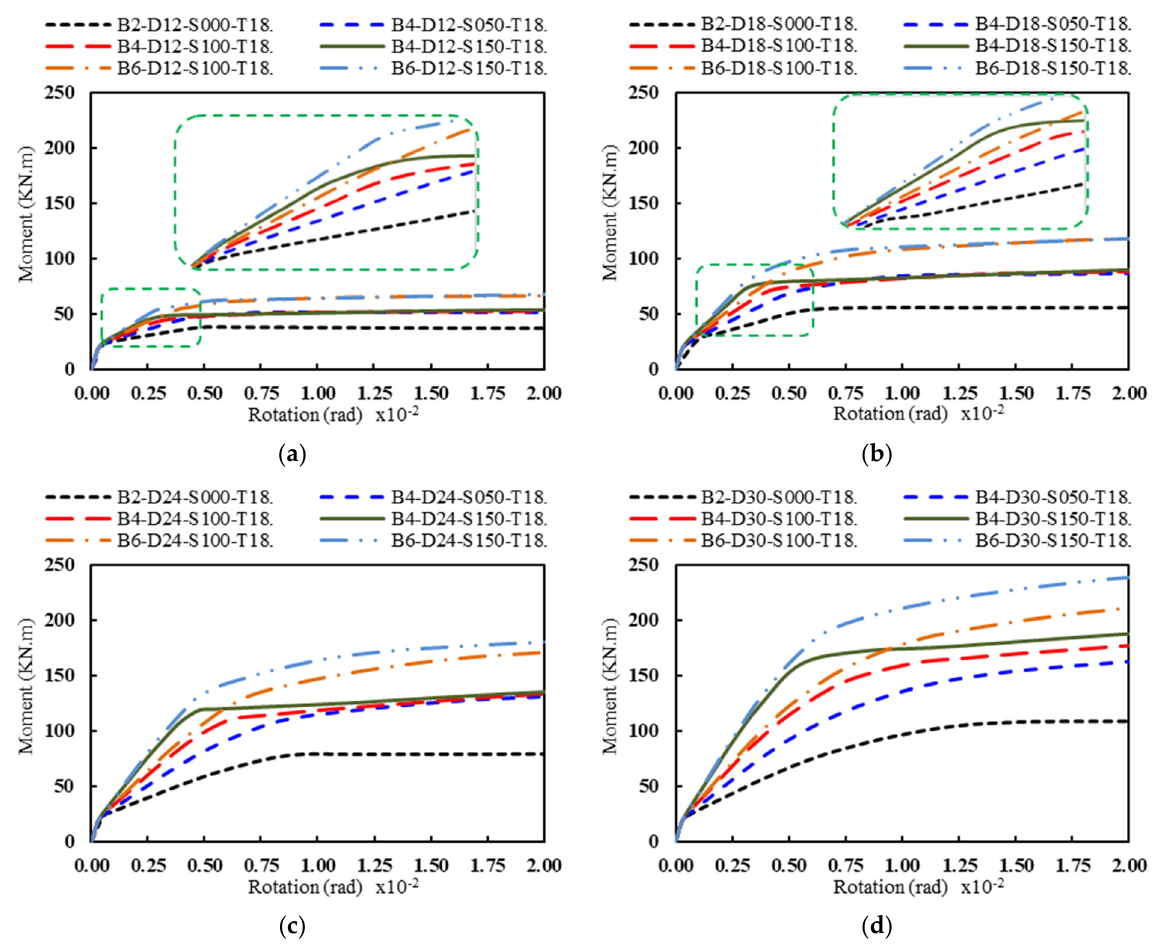
Figure 15. Effect of the anchor bolt number and spacing (S) on the rotational stiffness for different anchor bolt diameters (D): ( a ) D = 12 mm, ( b ) D = 18 mm, ( c ) D = 24 mm, and ( d ) D = 30 mm (the base plate thickness of 18 mm).